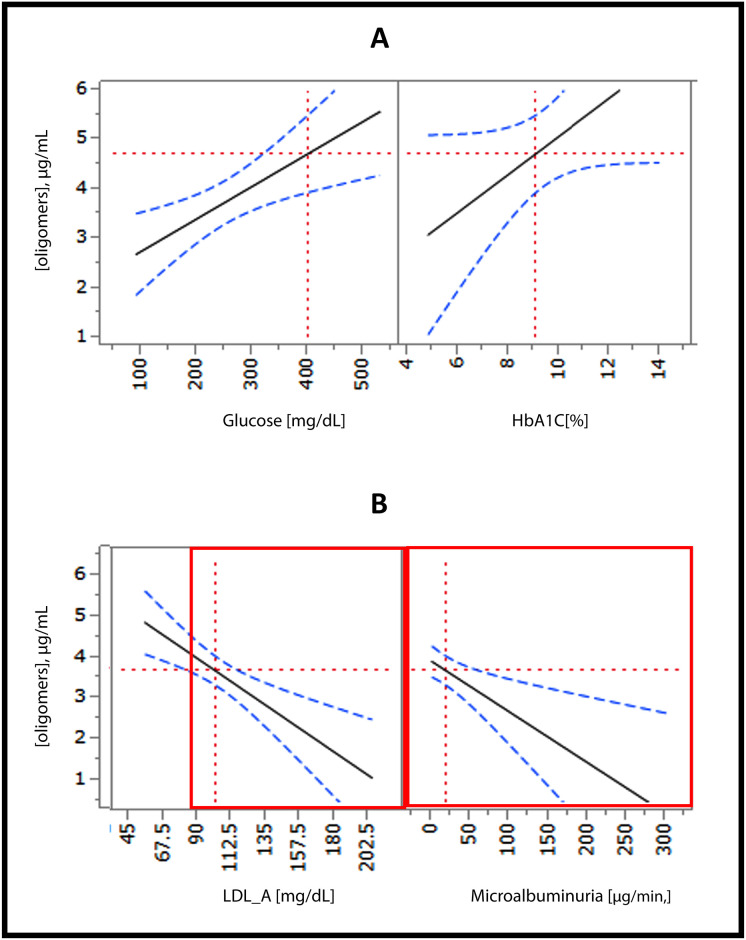
Linear regression analysis of the RIAO level and the values of glucotoxicity and its complications.A. The relationship between RIAO level and glucose or HbA1c: when glucose = 400 mg/dl or HbA1c = 9.072% then RIAO level = 4.72 μg/ml; [R2 = 0.70, p = 0.001]. B. The relationship between RIAO level and LDL or microalbuminuria; when LDL >100 mg/dl; or microalbuminuria >20 μg/min then RIAO level = 3.74 μg/ml; [R2 = 0.49, p = 0.001].